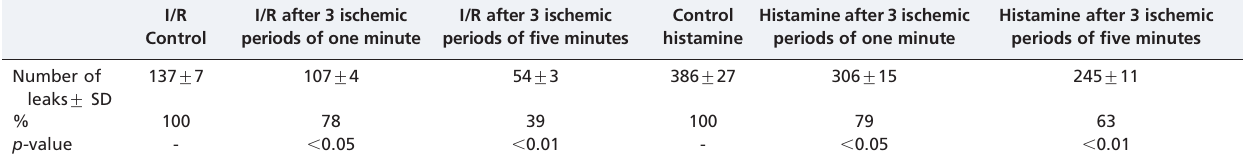
Table 1 - Comparison of the effects of three ischemic periods (of one minute or three minutes duration) on subsequent I/ R (30min) and on histamine (2 m M) induced plasma